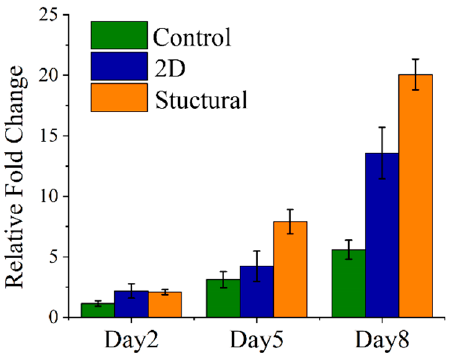
Figure 5. Viability of adult human dermal fibroblast (HDF) cells cultured for 8 days on different morphologies of PCL scaffolds.